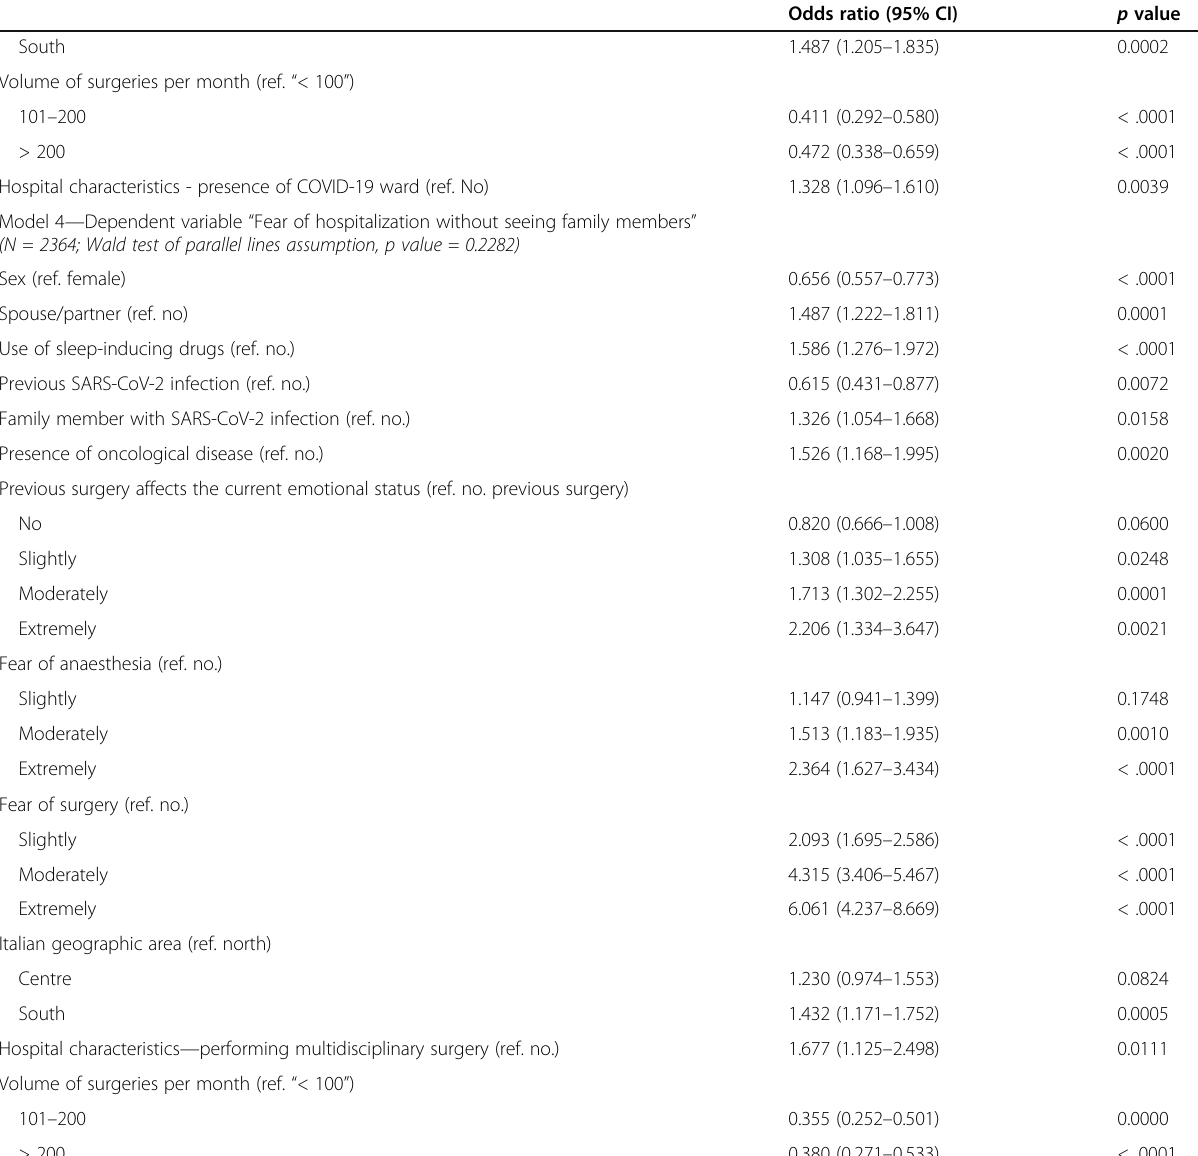
Table 2 Multivariable ordered logit models (Continued)